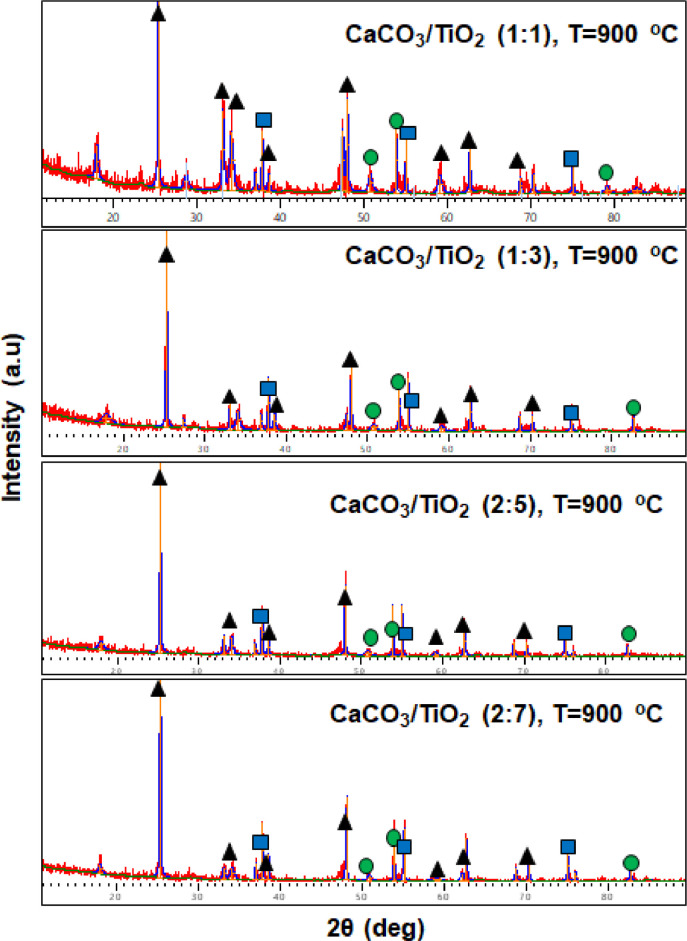
X-ray diffraction pattern of CaTiO3 prepared using different CaCO3/TiO2 molar ratio. Triangle (▲), square ( ▀) and circle (☻) denote CaTiO3, CaCO3, and TiO2, respectively.